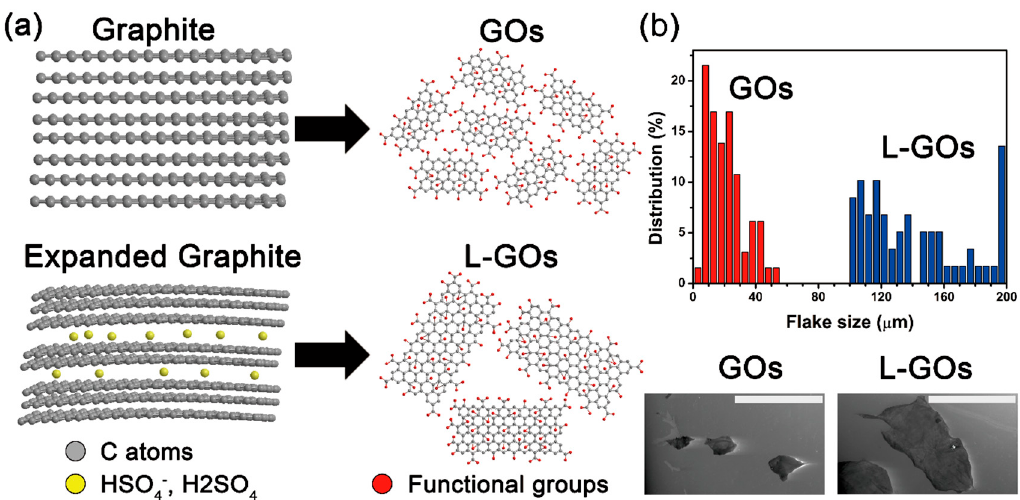
Figure 1. ( a ) Schematics for preparation of graphene oxides (GOs) and larger-sized GOs (L-GOs) from graphite (top) and expanded graphite (bottom), respectively; ( b ) distribution of lateral flake sizes of GOs and L-GOs (top) and their scanning electron microscopy (SEM) images (bottom). Scale bars in SEM images are 100 μ m.